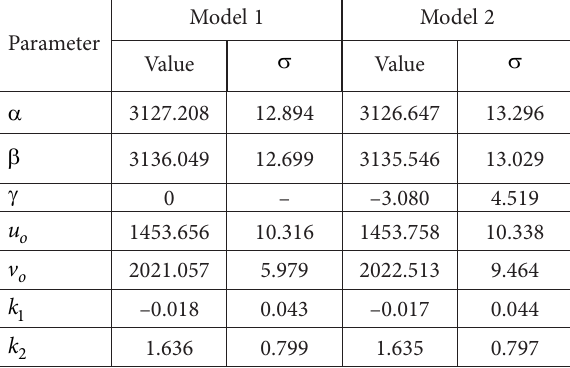
Table 3 . Intrinsic parameters and radial lens coefficients for